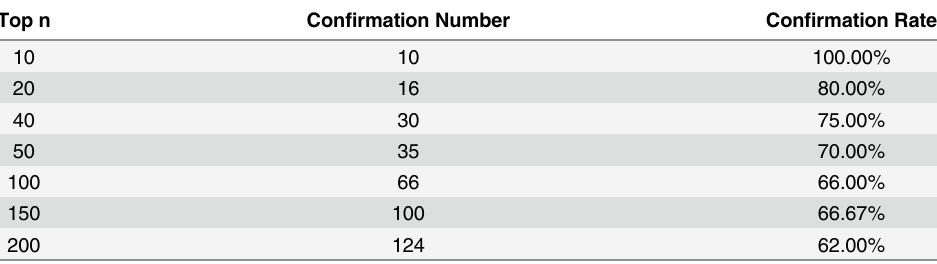
The con fi rmation rate was calculated by dividing the con fi rmation number by the corresponding number of top n. It represented the effectiveness of the con fi